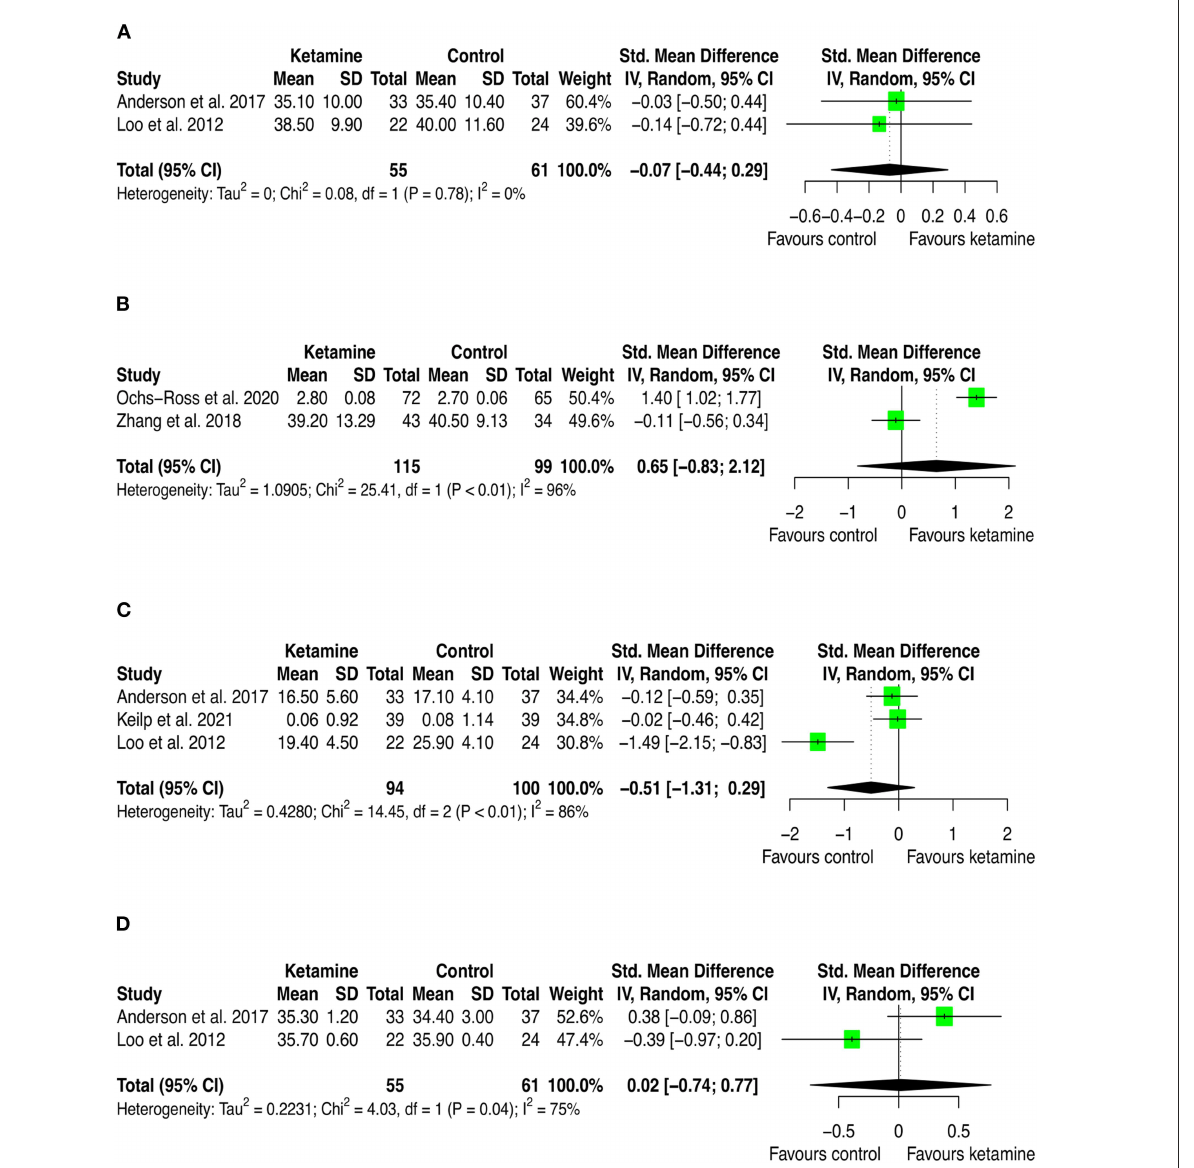
FIGURE2 Forest plots of performance comparisons among experimental and control groups on autobiographical memory interview short form (AMI-SF) (A) , Attention (B) , Category fluency (C) , Copy (D) . SD, standard deviation; IV, inverse variance; 95% CI, 95% confidence interval. x axis labels have been edited according to the characteristics of the outcome: since higher scores indicate better performance the label “Favors ketamine” is on the right-hand